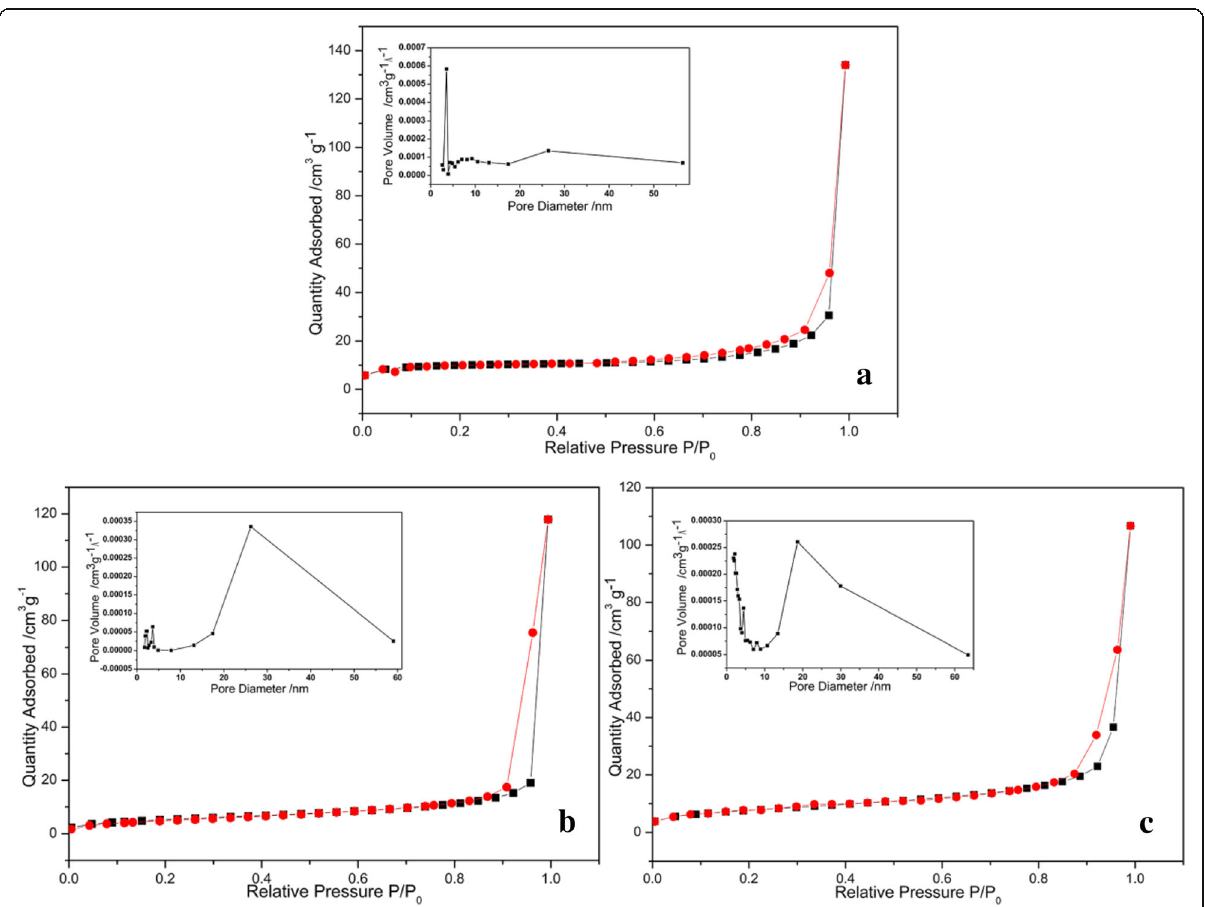
Fig. 5 Nitrogen adsorption-desorption isotherms and pore size distribution graphs of ACP-24-2 ( a ), ACP-48-2 ( b ), and ACP-48-10 ( c )